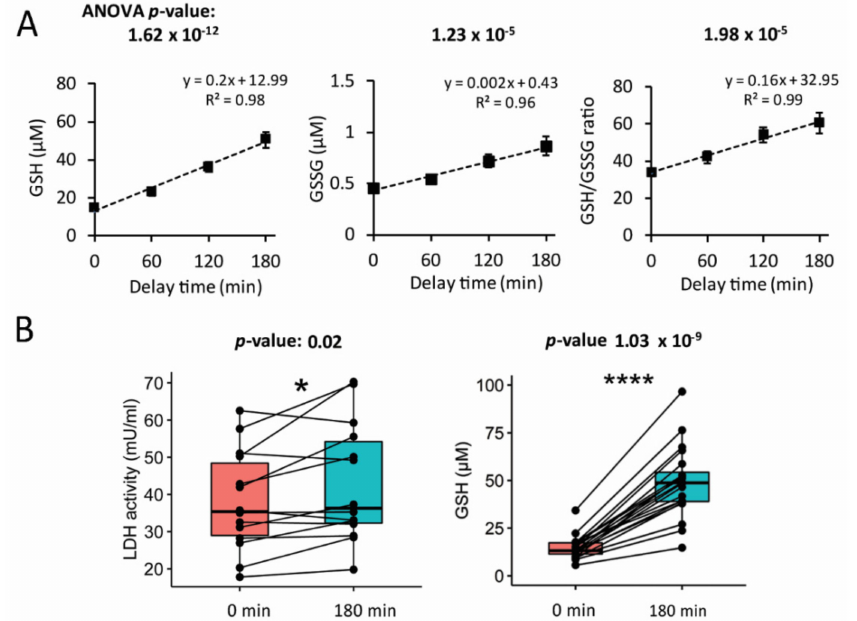
Figure 1. Concentrations of both GSH and GSSG increase over preparation delay time in plasma most likely due to hemolysis. ( A ) Absolute GSH concentration (left), GSSG concentration (middle), and GSH/GSSG ratio (right) content in the plasma of 20 volunteers after their blood was incubated for 0, 60, 120, and 180 min prior to plasma preparation. Points represent mean values ( n = 19 or 20) ± S.E.M on which linear regression was applied. ( B ) Lactate dehydrogenase activity assay (left panel, n = 14) suggests an increase in LDH activity in plasma over time (after 3 h of incubation at RT, *: p -value < 0.05). In comparison, GSH concentration increased with a steeper slope over time, and the difference of the start and endpoint was considerably larger as reflected by the lower p -value (right panel, n = 20, ****: p -value < 10 − 4